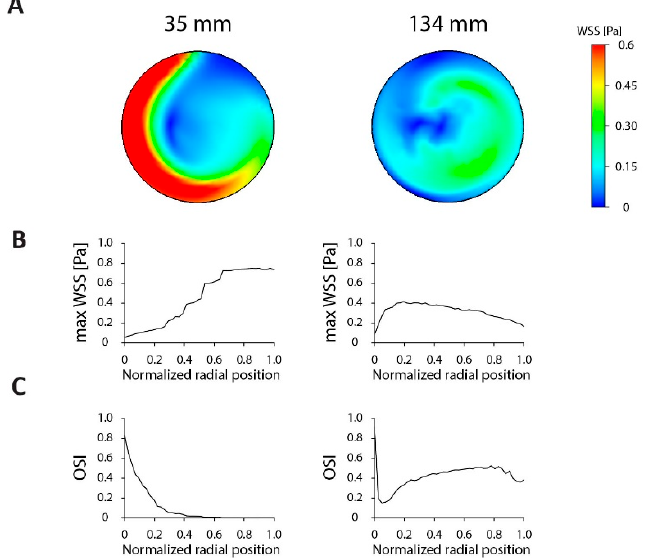
Figure 2. Comparison of shear stress distribution in standard culture dishes. ( A ) Heat map of the shear stress distribution in a six well plate (35 mm) and a 15-cm dish (134 mm). The dishes are scaled to equal size for shear stress comparison between dishes and the colored shear stress scale ranges from 0 to 0.6 Pa to display all shear stress distributions. For all situations, a 3-mm fluid height, 200-rpm rotational speed and a 10-mm orbit was used. ( B ) Maximum shear stress levels as a function of the radial position in the dish. ( C ) Oscillatory shear index (OSI) as a function of the radial position in the dish.